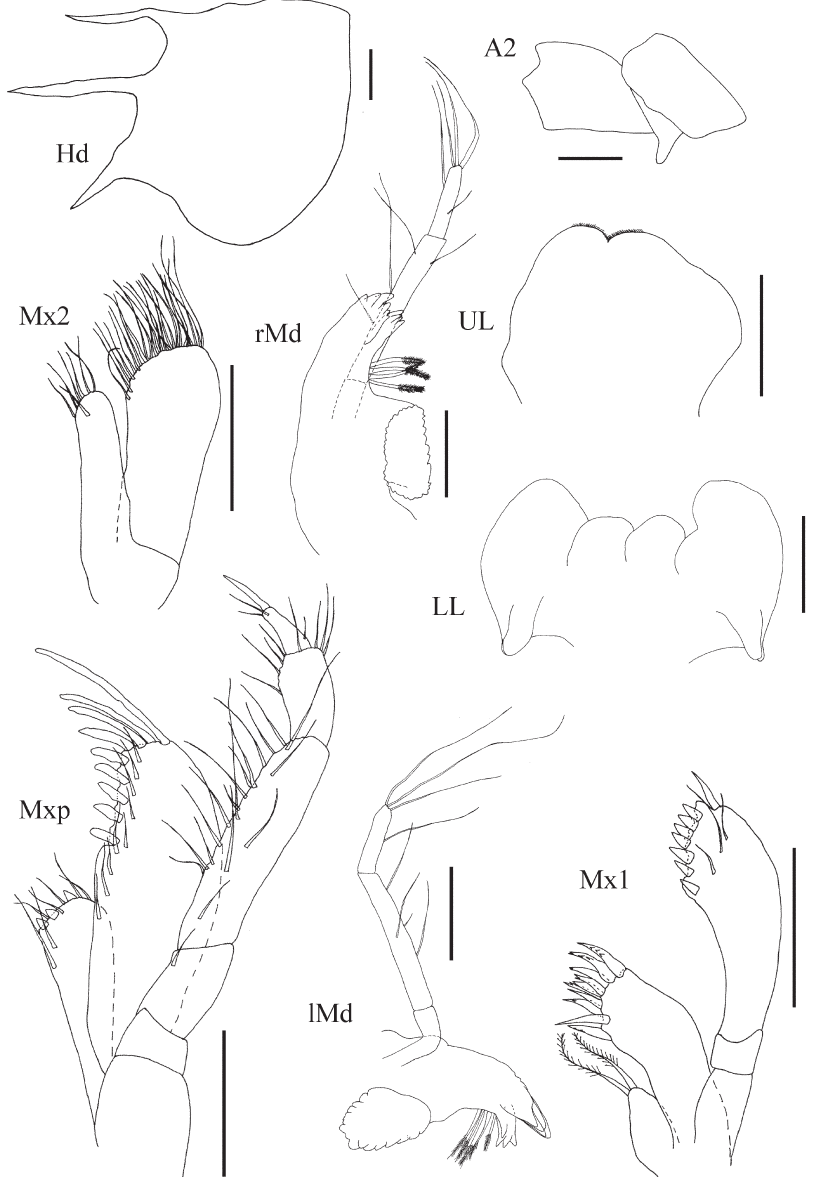
Fig . 8. – Lepechinella laurensi n. sp., holotype, male, 5.7 mm, MnrJ16485, oceanprof ii #58, 21°57’26.8”S, 39°40’34.0”w. Scale bars = 0.1